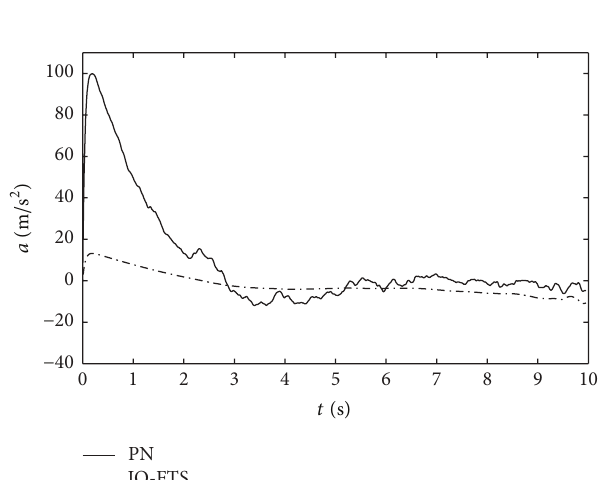
Figure 3: The LOS angular rate.